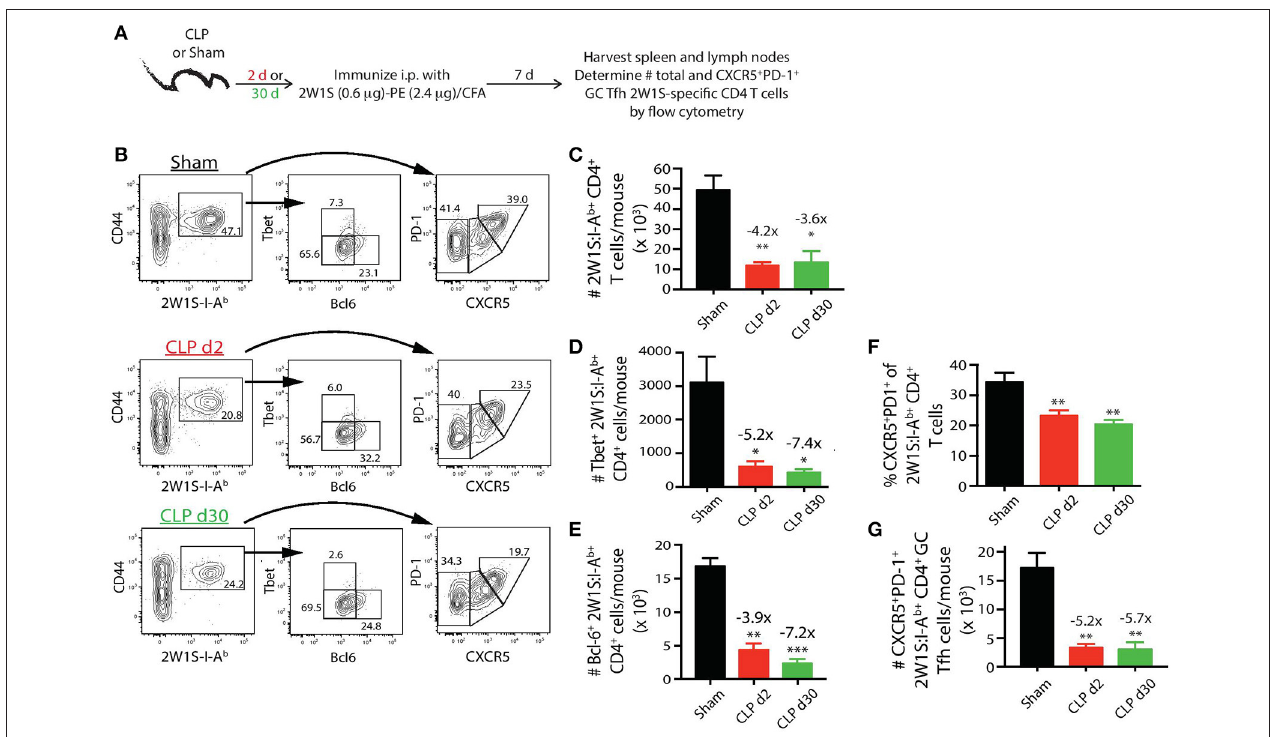
FIGURE 5 | Sepsis restricts the ability of 2W1S:I-A b -specific CD4T cells to differentiate into Tfh during a CD4T cell-dependent B cell response. (A) Experimental design—mice underwent sham or CLP surgery and were then immunized on day 2 or 30 after surgery with 2W1S-PE/CFA i.p. Spleens and peripheral lymph nodes were harvested 7 days after immunization and combined. (B) Gating scheme used to identify 2W1S:I-A b -specific CD4T cells (CD8T cells were used as the internal negative control for tetramer binding), as well as the 2W1S:I-A b -specific CD4T cells expressing Tbet, Bcl-6, or PD-1 and CXCR5. The frequency of cells within the gated populations is indicated. The number of (C) total, (D) Tbet + , (E) Bcl-6 + 2W1S:I-A b -specific CD4T cells, as well as (F) frequency, and (G) number of 2W1S:I-A b -specific CD4T cells expressing CXCR5 and PD-1, was determined. n = 5–7 mice/group. Statistical comparisons were made between sham-treated mice and either CLP d2- or d30-treated mice, where * p < 0.05, ** p < 0.01, and *** p < 0.005. Data are representative of at least 3 independent